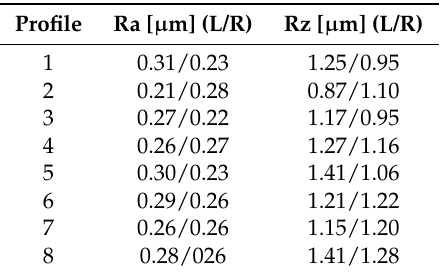
Table 16. Surface roughness values for hard machining with special inserts of type 1010.